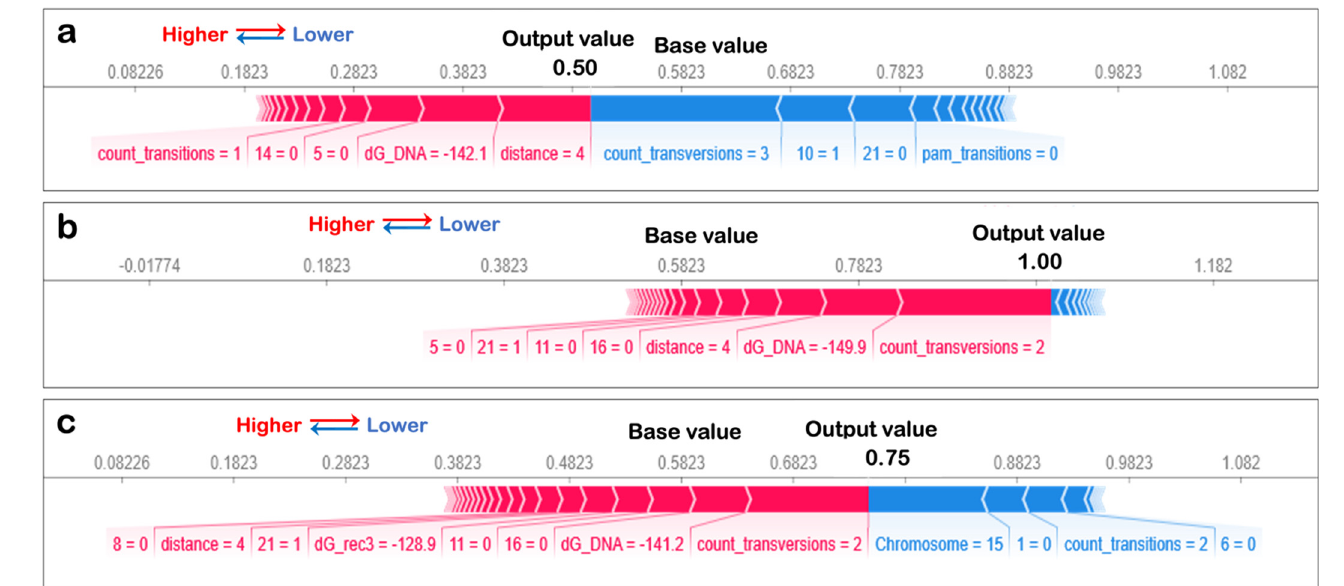
Figure 5. SHAP value plots for singular datapoints. Examples shown are for dataset indices ( a ) 10, ( b ) 17 and ( c ) 21, and are chosen randomly. The base value shown increases by features shown in red and decreases because of features shown in blue. Each feature impacts the value in magnitude indicated by SHAP values labelled alongside for each instance.